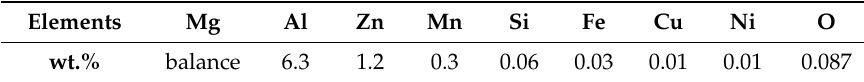
Table 1. Chemical composition of